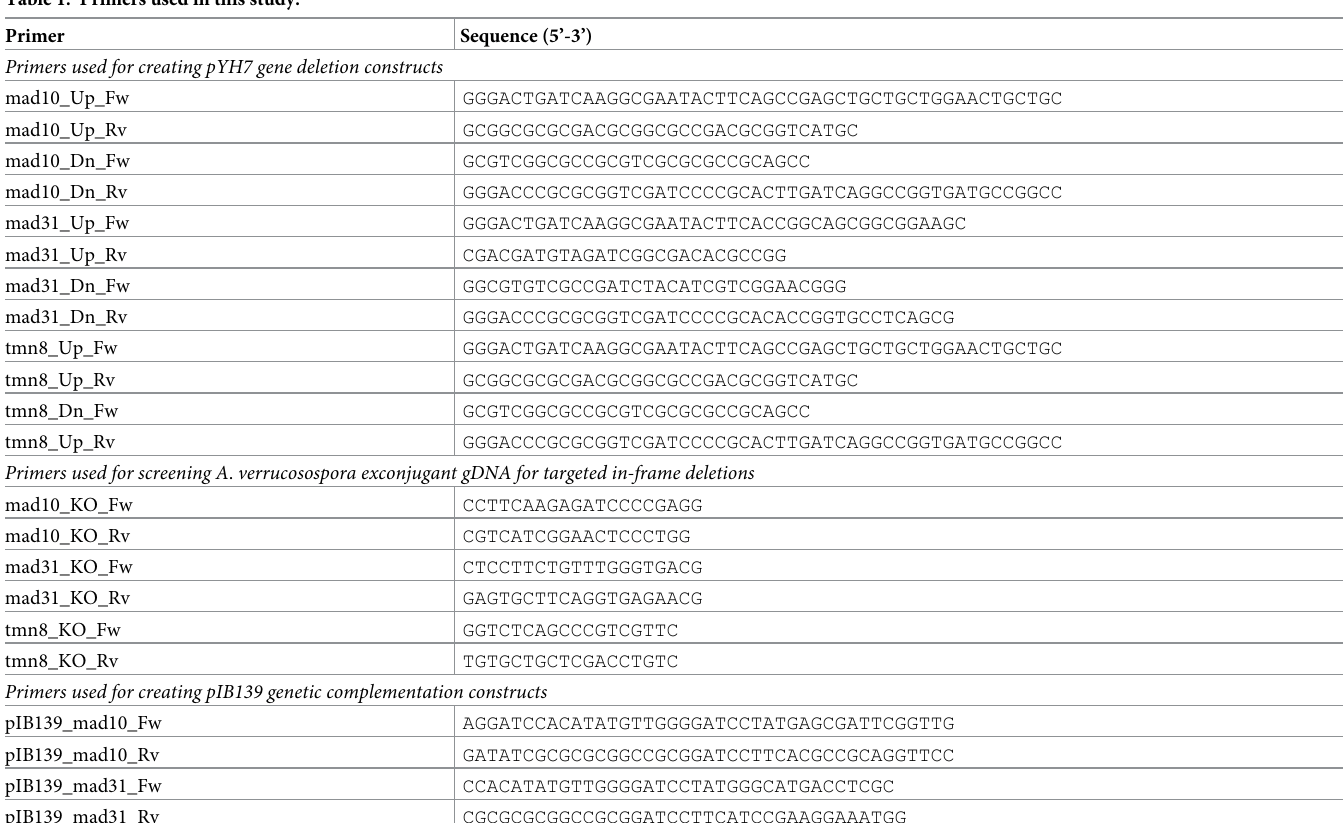
Table 1. Primers used in this study.